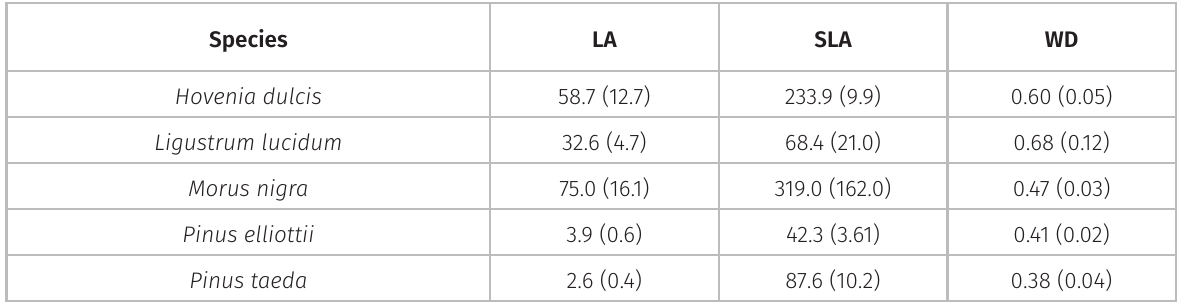
LA: leaf area (cm²); SLA: specific leaf area (cm 2